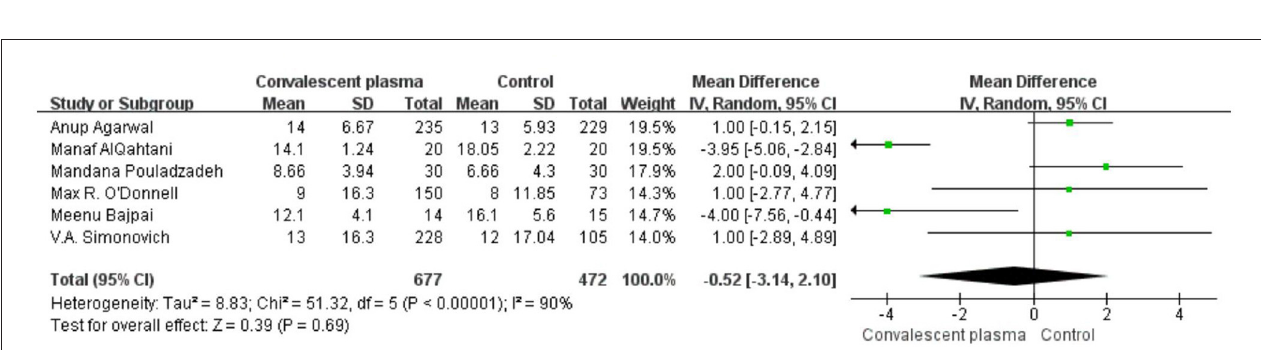
FIGURE 6 | Forest plot of mean difference (MD) of hospital stay among patients treated with convalescent blood products and controls ( n = 6 studies). Weights are from fixed-effects analysis. CI, confidence interval.